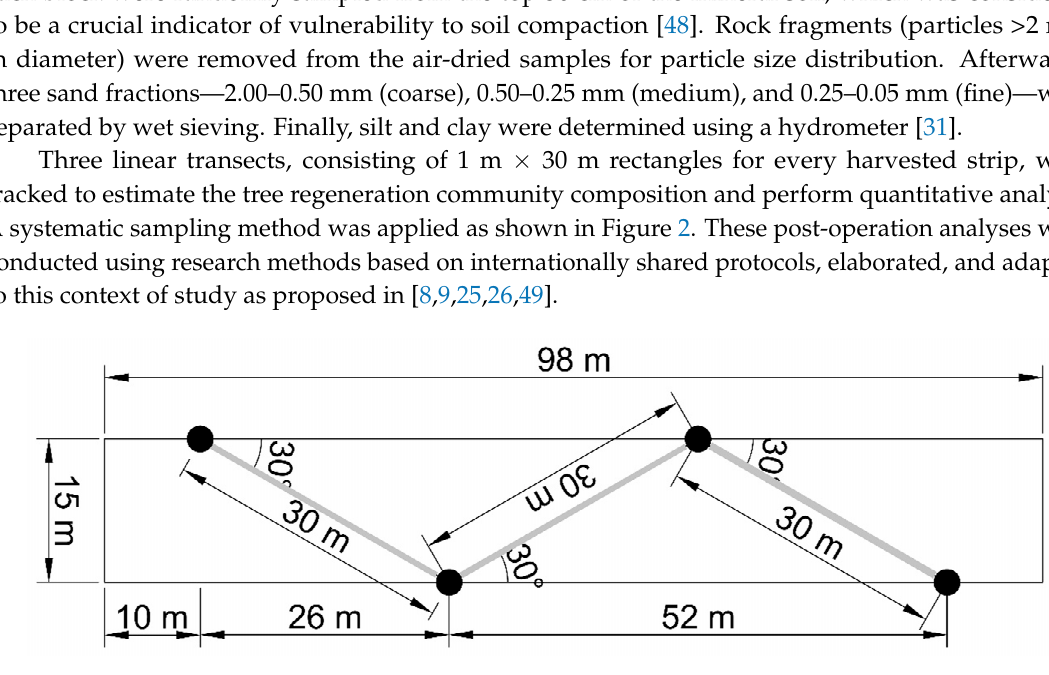
Figure 2. Scheme of the systematic sampling method applied in every harvested strip. The black points are only the starting points of every linear transect (grey lines).